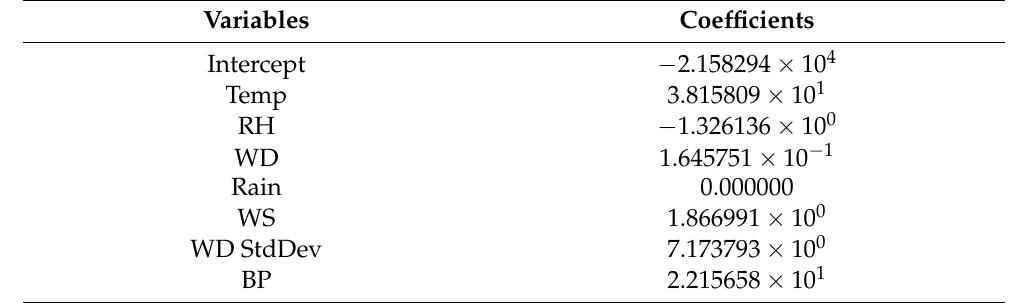
Table 4. Parametric coefficients.